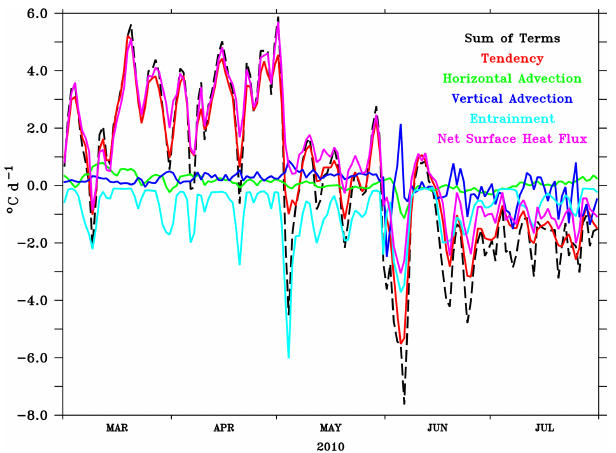
Figure 11. Mixed-layer heat budget analysis in the north–central Arabian Sea (19 ◦ N, 63 ◦ E). The “sum of terms” represents the sum of all terms on the right side of Eq.